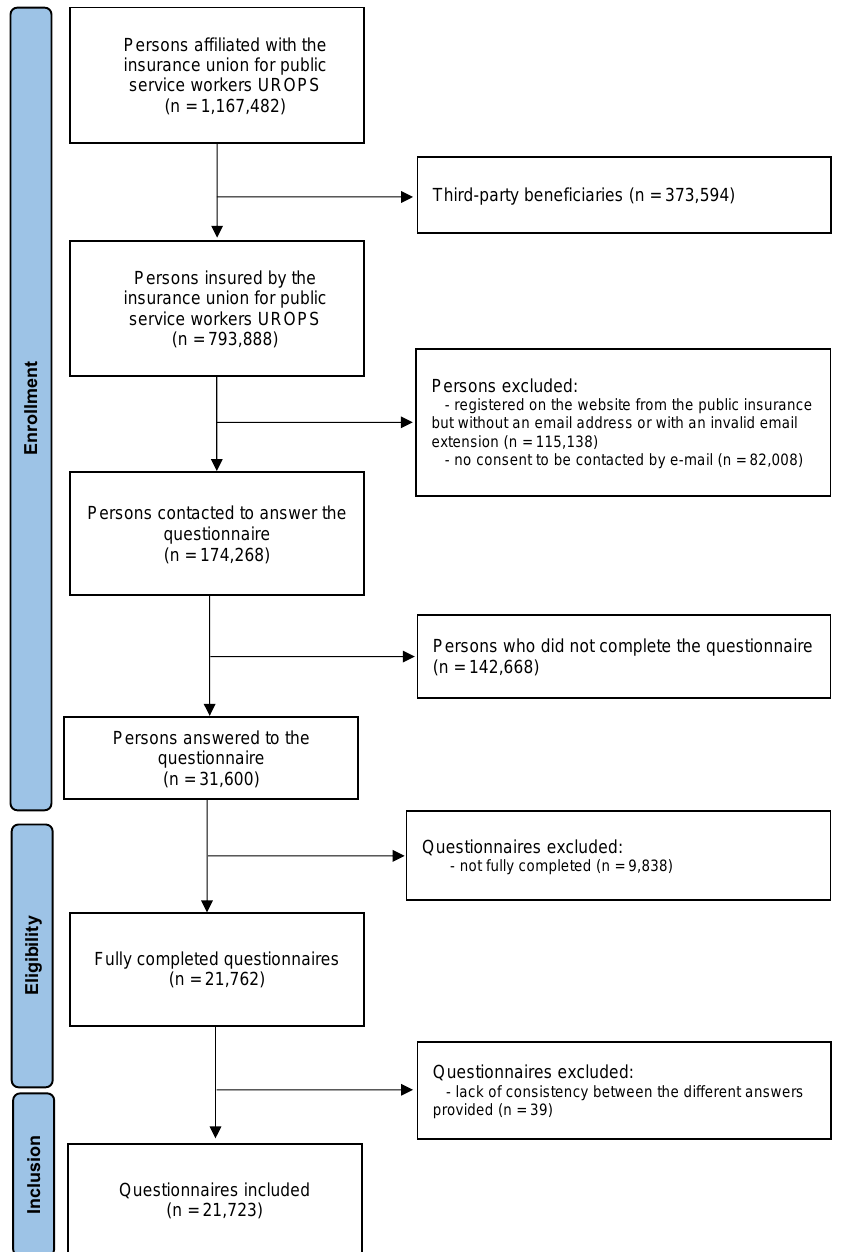
Figure 1. Flowchart of the study. UROPS: Union Prévention Santé pour la Fonction publique. The final sample comprised 21,723 included respondents of whom 71.3% completed the survey using a laptop (15,482) and 29.7% a cell phone (6241). Among the included respondents, 47.0% were under 60 years old (10,206) and 53.0% were over 60 years old (11,517) (Supplementary Section S4: Figures S1 and S2). The age ranged from 18 to 80 years and older. The gender distribution was 41.1% males (8938) and 58.9% females